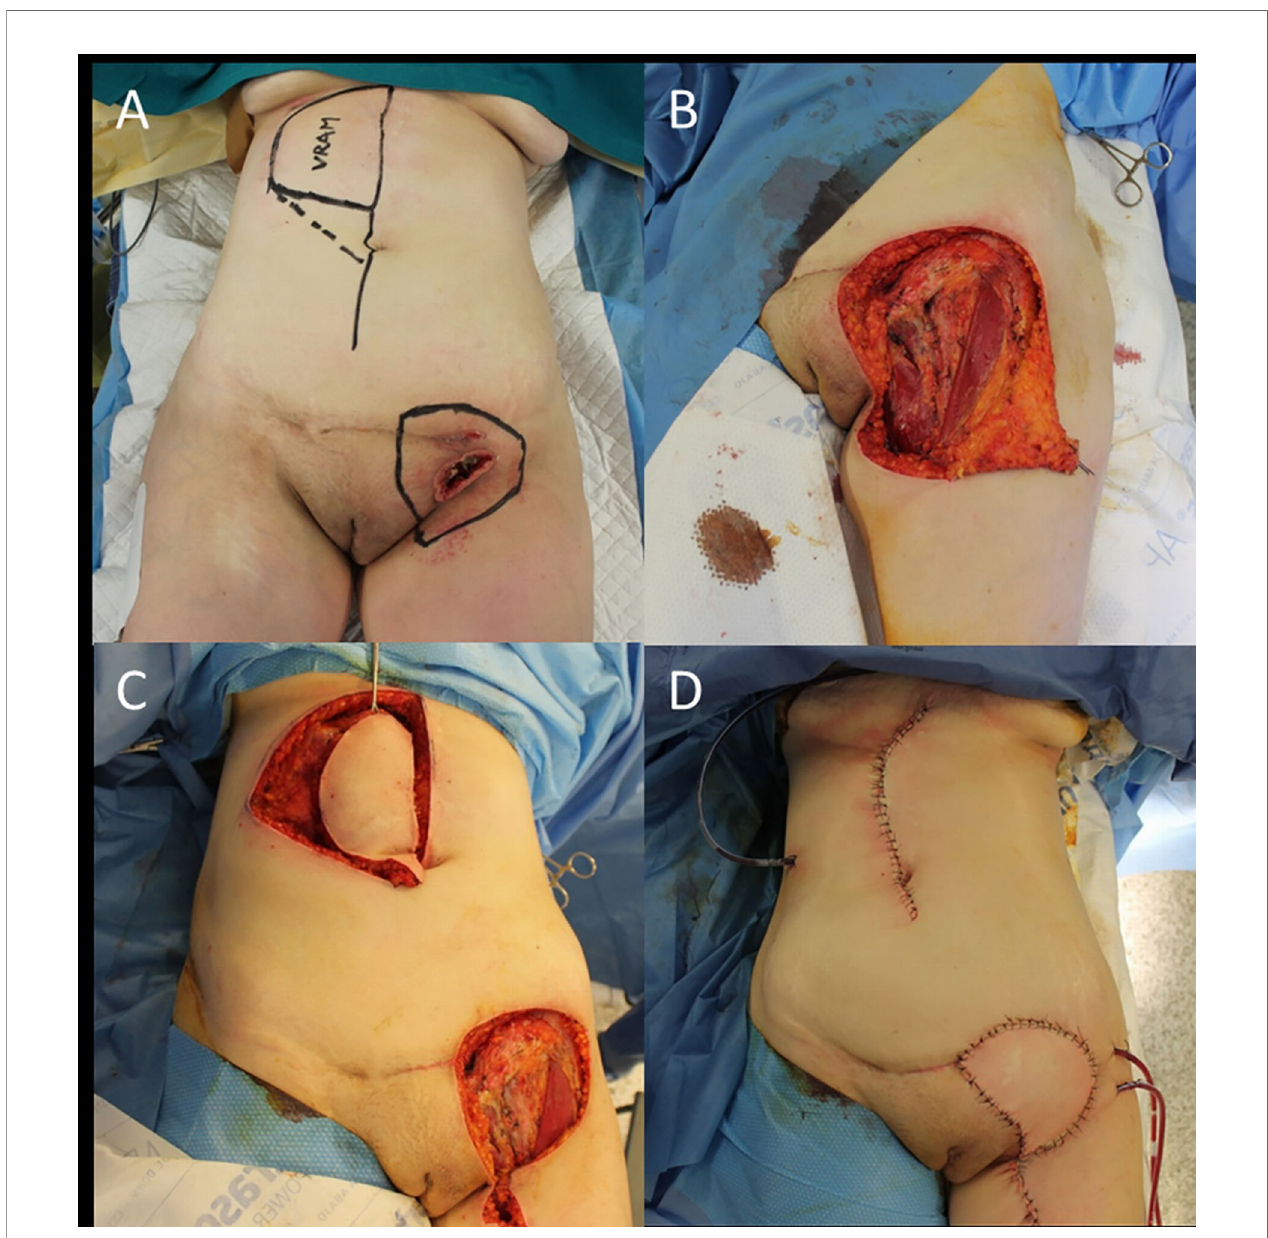
FIGURE 2 | (A) Recurrent cSCC of the vulva after surgery and radiotherapy, outlined the groin excision limits and the boundaries of the right vertical rectus abdominis muscle (VRAM) fl ap; (B) End of the wide excision and groin dissection; (C) Harvest of the VRAM fl ap; (D) Final result after fl ap